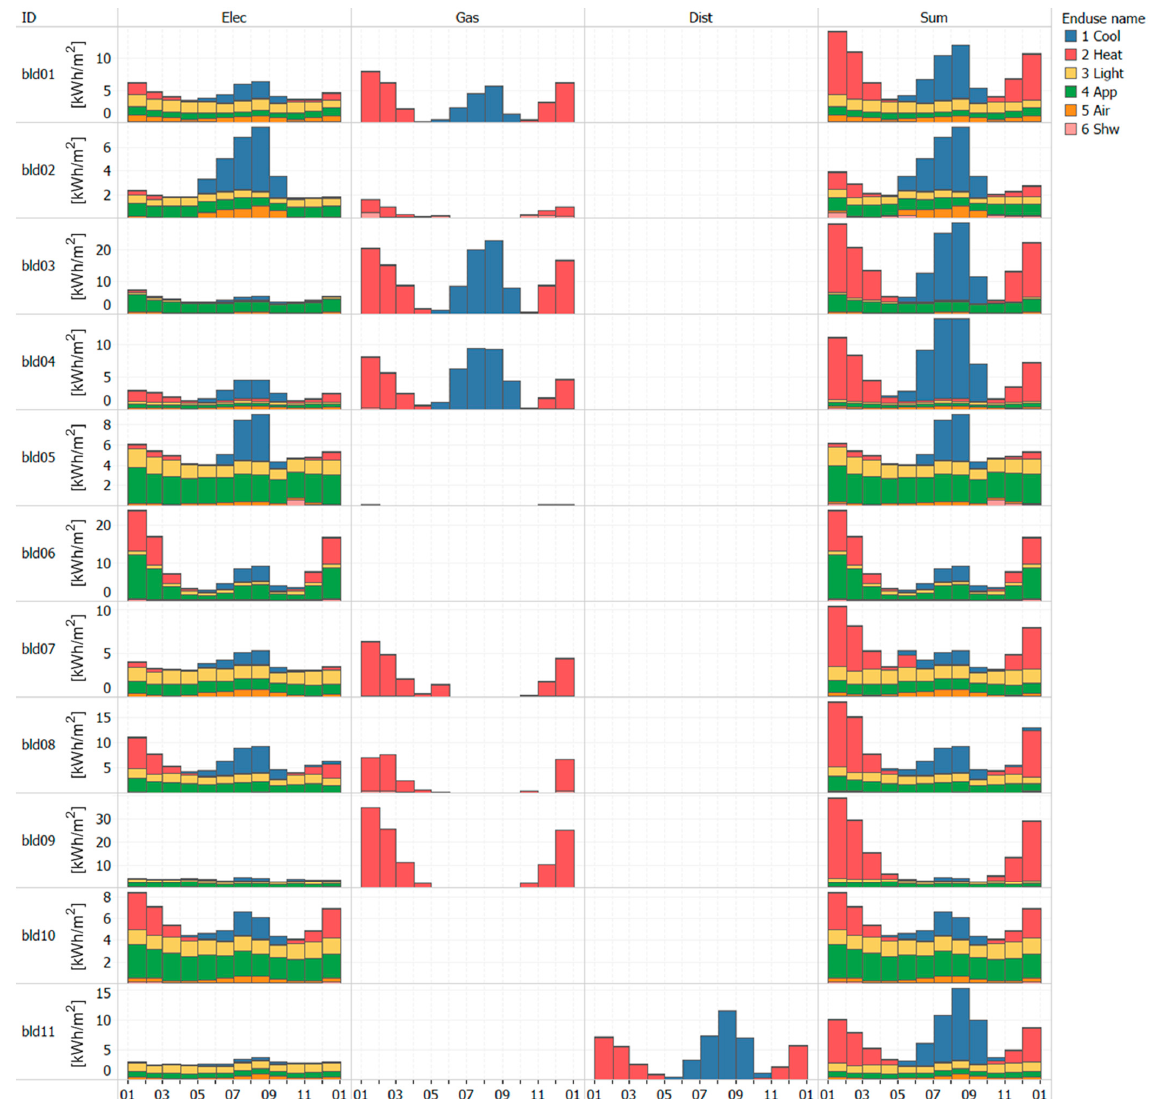
Figure 4. Monthly energy end-uses profiles of eleven buildings (Elec: electricity, Gas: city gas, Dist: district heating).